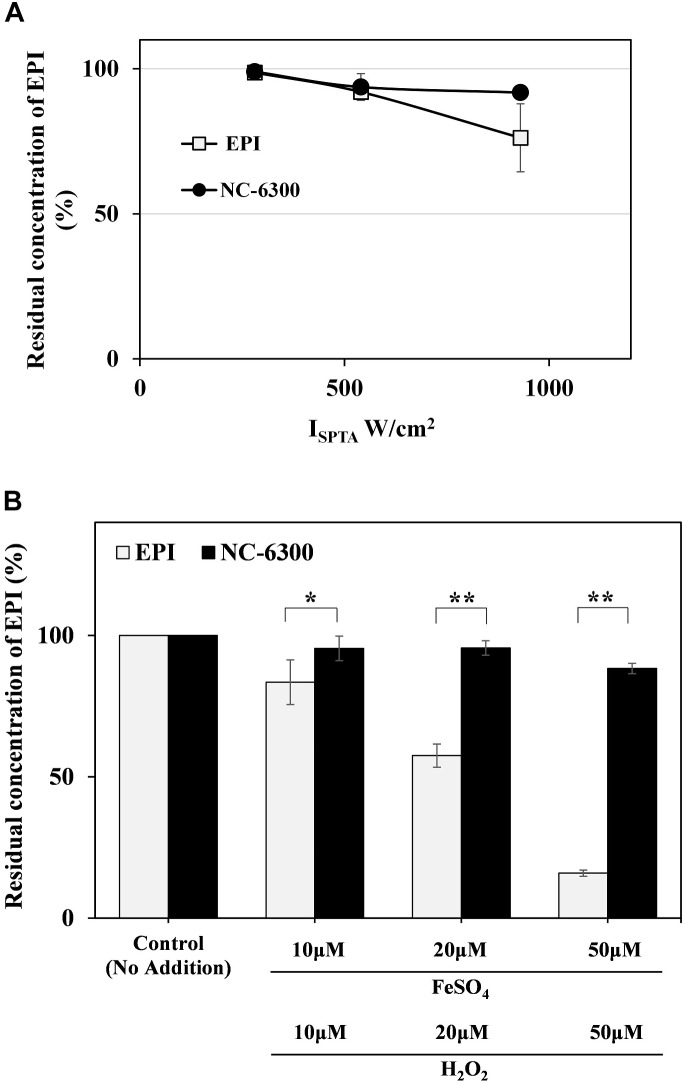
(A) EPI degradation test by TP-HIFU irradiation. The sample solution containing NC-6300 or EPI (0.1 mg/mL EPI concentration) was irradiated 10 min by TP-HIFU in test tube made of glass. Residual amount of EPI was calculated with non-irradiated sample set to 100%. The irradiation groups were collected as three samples and presented as the mean ± standard deviation. (B) EPI degradation test by Fenton reaction. The sample solution containing NC-6300 or EPI (0.01 mM EPI concentration) was treated with Fenton reaction in test tube. The residual amount of EPI was measured by HPLC (n = 2–3) and presented as the mean ± standard deviation. ∗P < 0.05, ∗∗P < 0.01, comparison for each pair by Tukey–Kramer test.